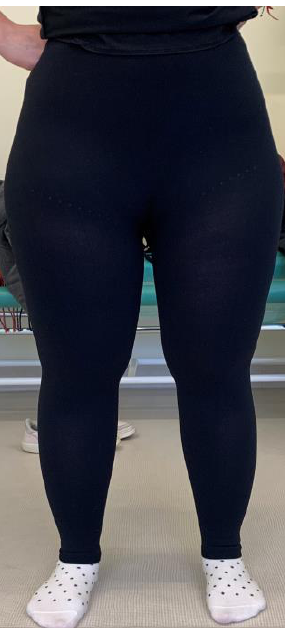
Figure 1. Lipedema patient wearing compression